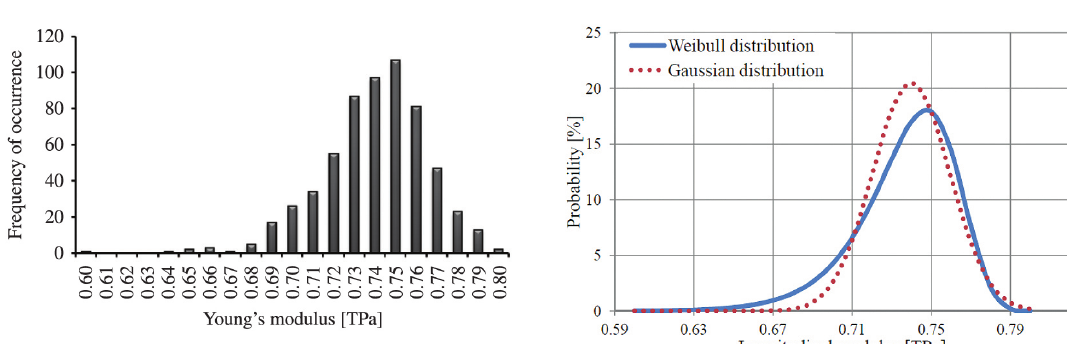
Figure 14. The frequency of defected CNT (12,0) with 5% of the defect density in 600 runs.